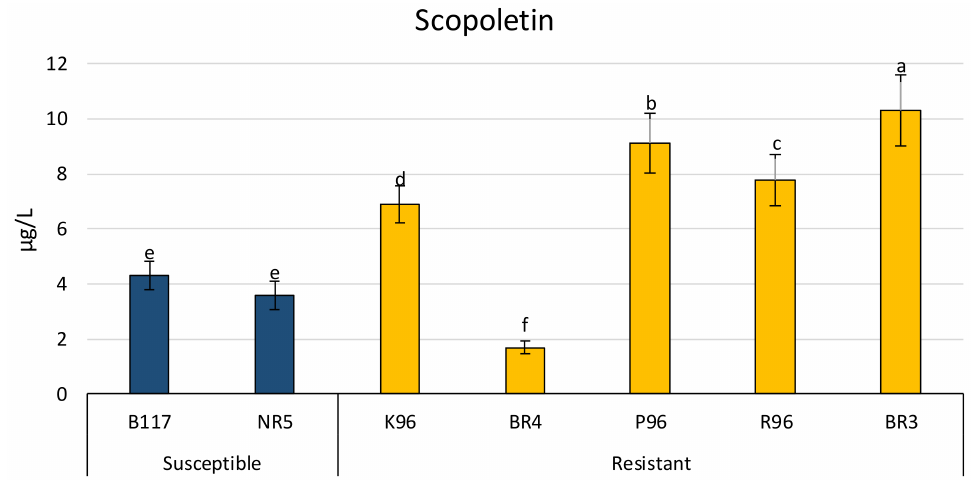
Figure 6. Concentrations of scopoletin in sunflower root exudates of five resistant varieties (BR4, P96, BR3, K96, and R96) and two susceptible varieties (B117 and NR5). Different letters indicate significant difference ( p < 0.05) according to one-way ANOVA followed by Newman–Keuls test. Similar letters indicate non-significant